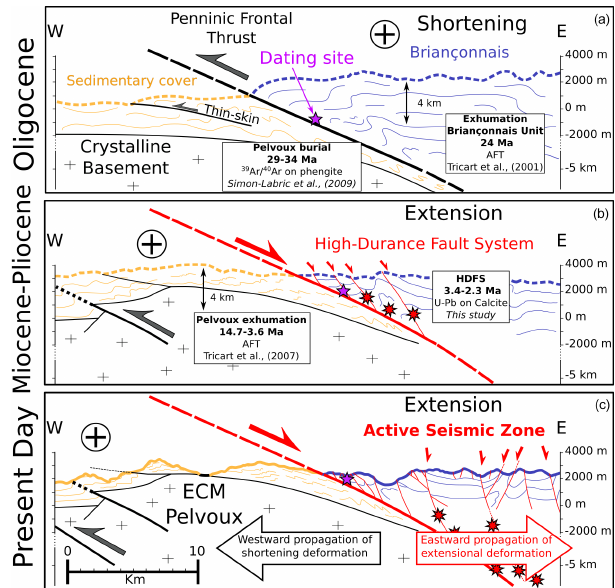
Figure 9. Evolutionary geological cross-section sketch of PFT; position and geometry of main faults from Tricart et al. (2006). (a) Compressional activation of the PFT resulting in joint exter- nal crystalline massif burial and Briançonnais exhumation during the Oligocene. (b) Extensional reactivation of the PFT and setting up of the High Durance fault system during the Pliocene as evi- denced in this study. At this point the dated extensional fault passes through the upper boundary of the seismic zone at ca. 2–3Ma. (c) At present day, compressional deformation has migrated west- ward (frontal part of external crystalline massifs, since ca. 15Ma), and extensional seismic activity of the High Durance fault system is recorded at shallow depth 3–10km east of the studied palaeoseismic